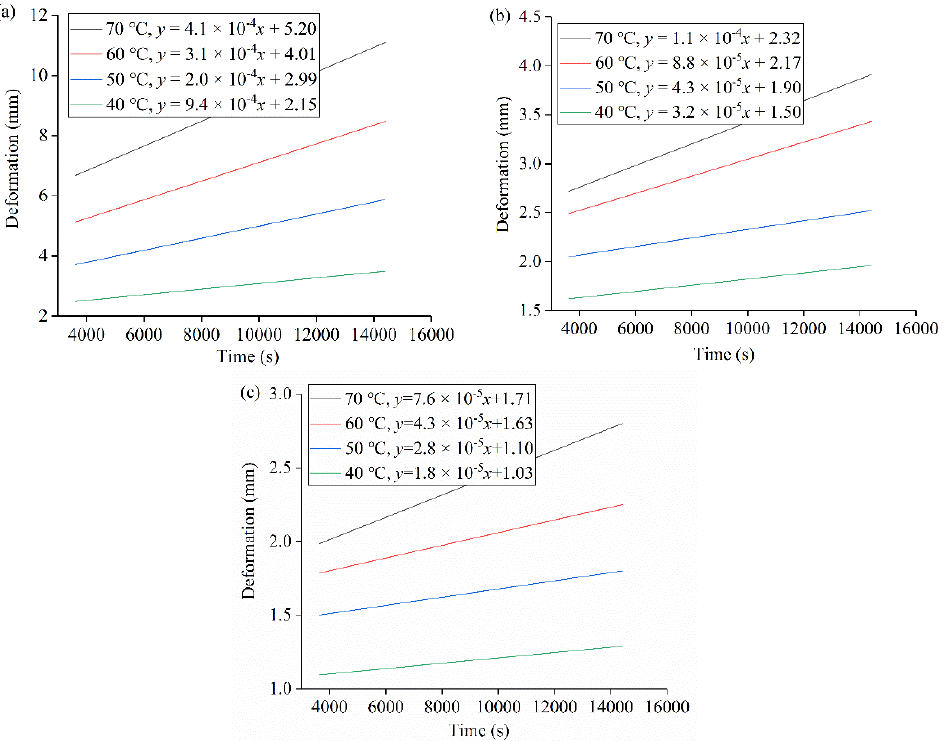
Figure 4. The relationship between deformation and loading time of the three asphalt mixtures: ( a ) matrix AC-16; ( b ) SMA-16; ( c ) modified AC-16.